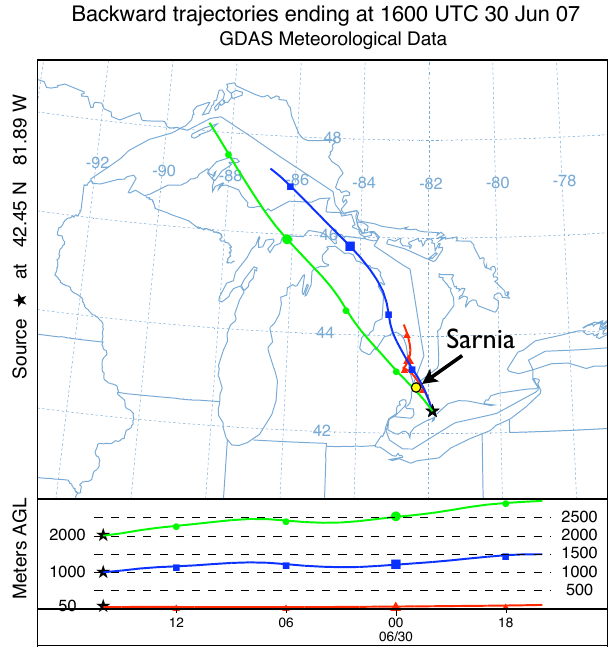
Fig. 14. HYSPLIT back trajectory for Ridgetown (starred) on 30 June 2007. Time scale in